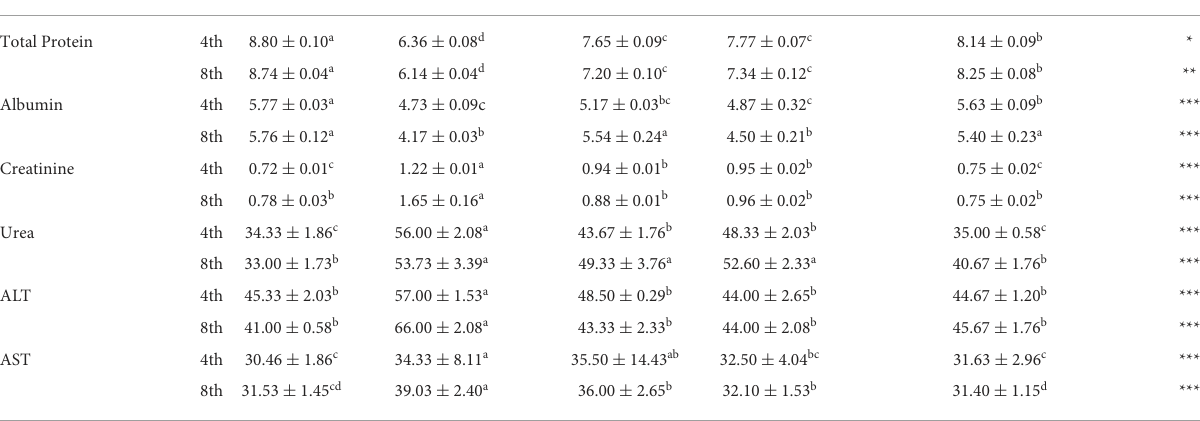
TABLE 1 Serum Biochemical Parameters (mg//dl) and in control, Allium sativum and Nigella sativa at fourth and 8th week during exposure to aluminum 1,600 ppm toxicity ( n = 20/group, mean ± SEM). Parameter (mg//dl) Time Control Aluminum 1,600